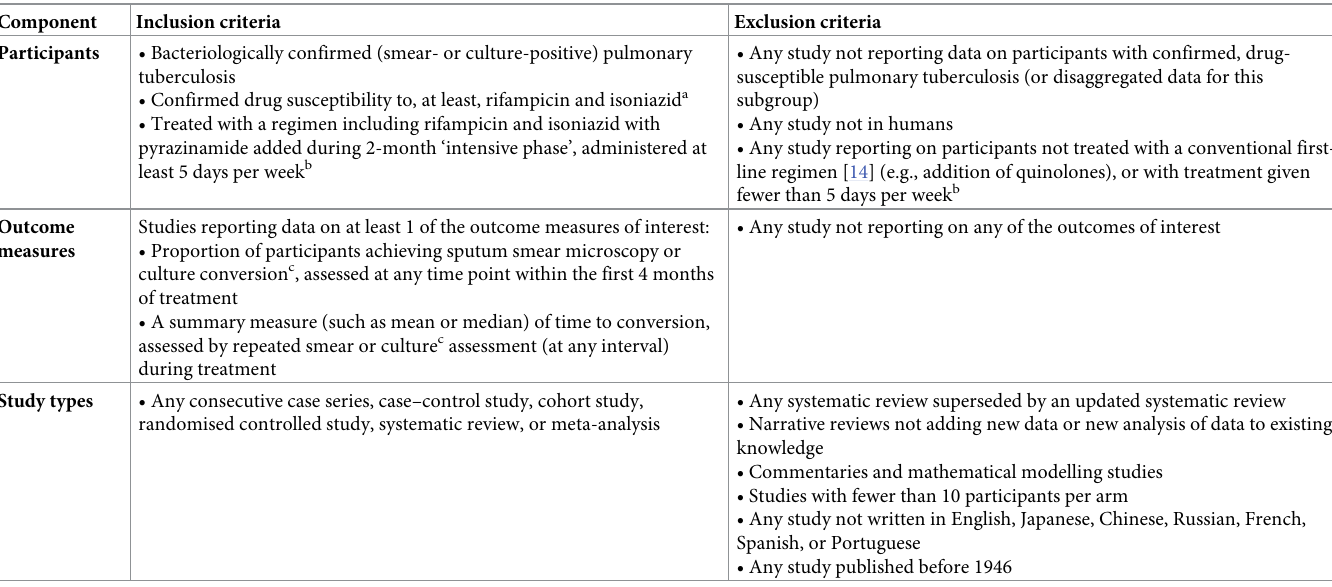
Table 1. Summary of inclusion and exclusion criteria employed during record